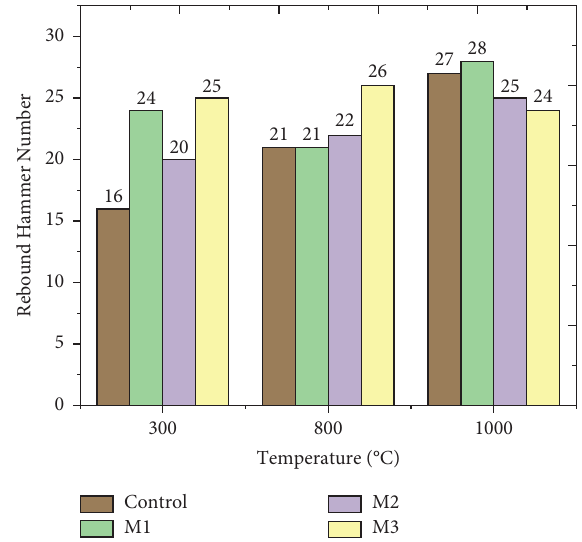
Figure 9: Rebound number of concrete samples at varying